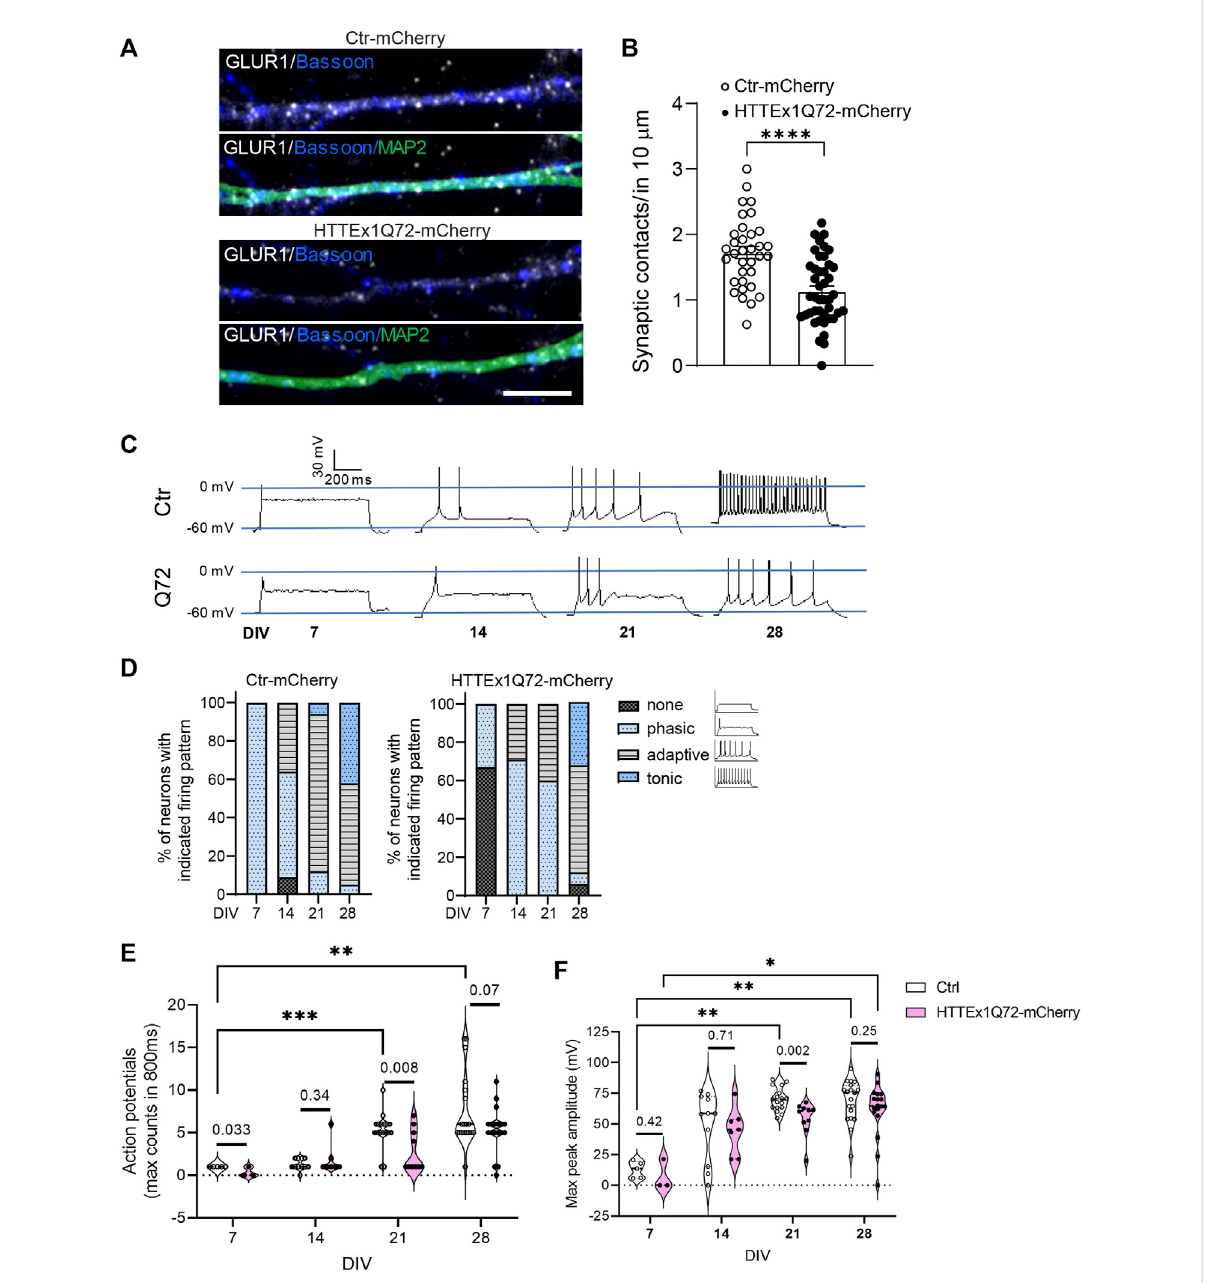
FIGURE 3 Neuronal maturation is delayed in HTTEx1Q72-mCherry neurons. (A) Indirect immuno fl uorescence representative images of dendrites from Ctr-mCherryand HTTEx1Q72-mCherry neurons onDIV30visualizingMAP2 and thesynaptic markers Bassoonand GLUR1. (B) Quanti fi cationofthe number of synaptic contacts, de fi ned as close opposition between GLUR1 and Bassoon in 10 µm of dendrites ( n = 30 – 40 cells from three independent cultures; p < 0.0001****unpaired Student's t-test). (C) Representative current-induced fi ring pattern of individual Ctr-mCherry and HTTEx1Q72-mCherry neurons at different weeks ofculture. (D) Graphs displaythe percentageof neurons with indicated current-induced fi ring patterns recorded on DIV 7 – 28. (E,F) Quanti fi cation of the maximum number of action potentials counted in 800 ms (E) and quanti fi cation of the maximum peak amplitude (F) measured on DIV 7 – 28 ( n = for DIV 7: 3 – 5, for DIV 14 – 28: 10 – 20; p < 0.03*, p < 0.002**, and p < 0.0002***, two-way ANOVA mixed-effect model; exact p -values: unpaired Student's t-test. Scale bar = 5 µm. All averaged data are shown as mean ±